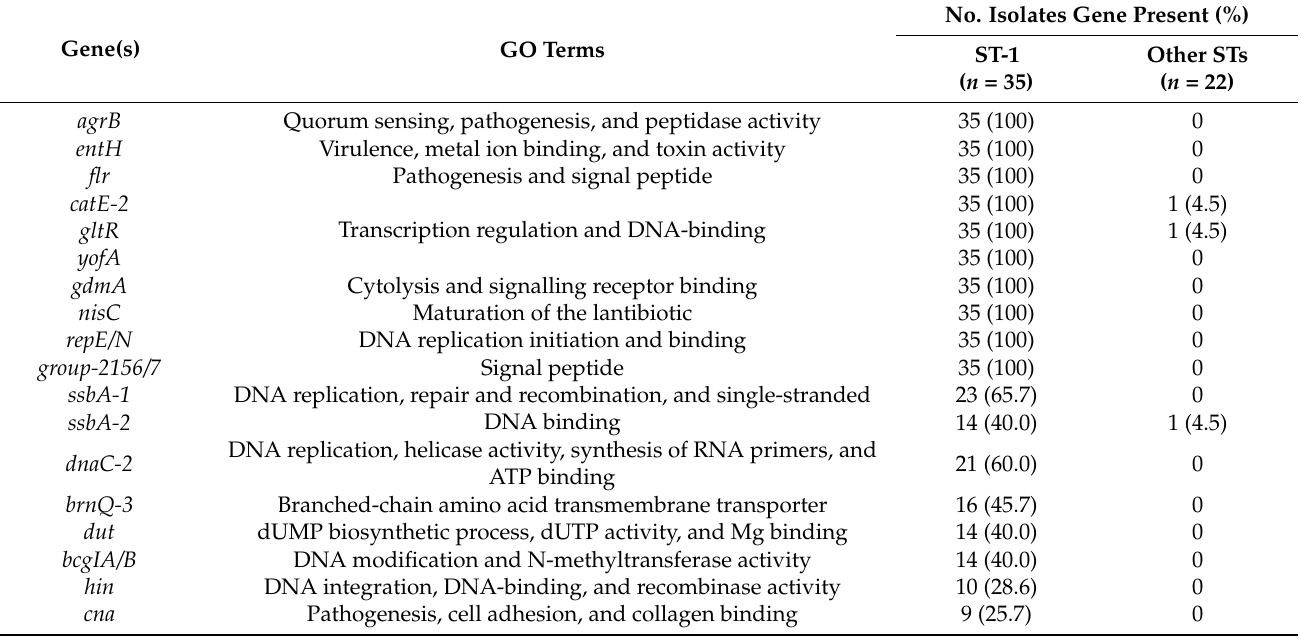
Table 3. Scoary result summary showing the genes found to be significantly associated with S. aureus sequence type (ST)-1 and the Gene Ontology (GO) terms indicating either the biological processes or molecular functions associated with the gene